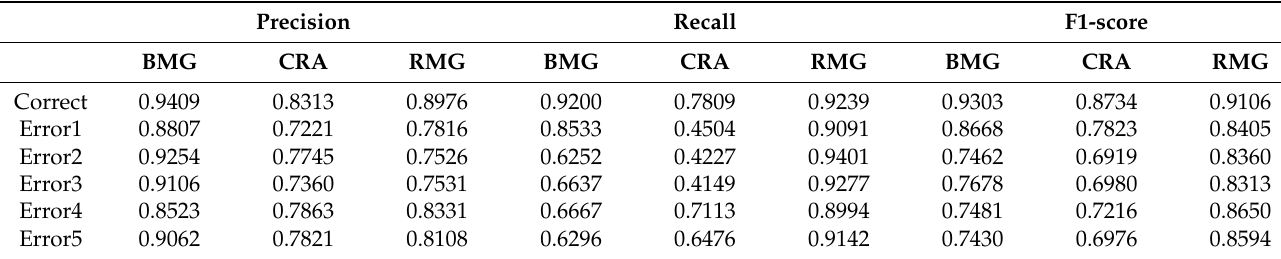
Table 6. F1-score, Recall, and Precision of different cost